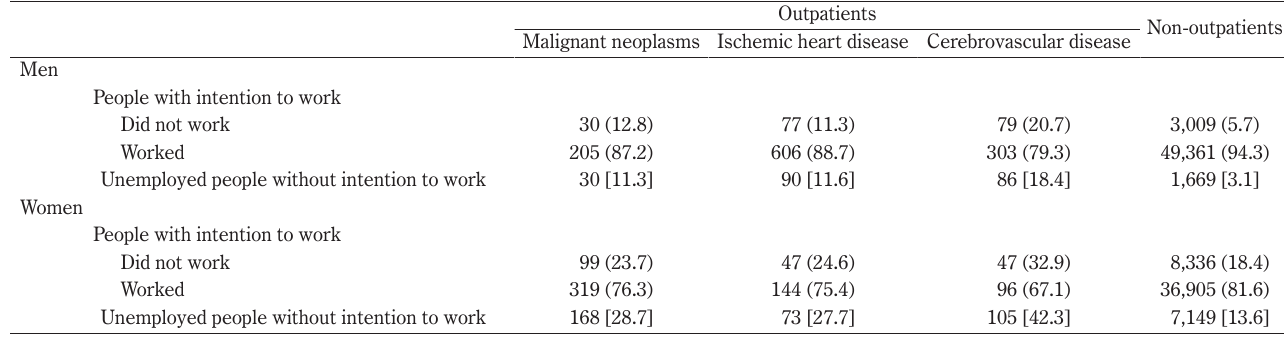
Table 2 Proportions by work and intention to work among outpatients with malignant neoplasms, ischemic heart disease, and cerebrovascular disease, and non-outpatients